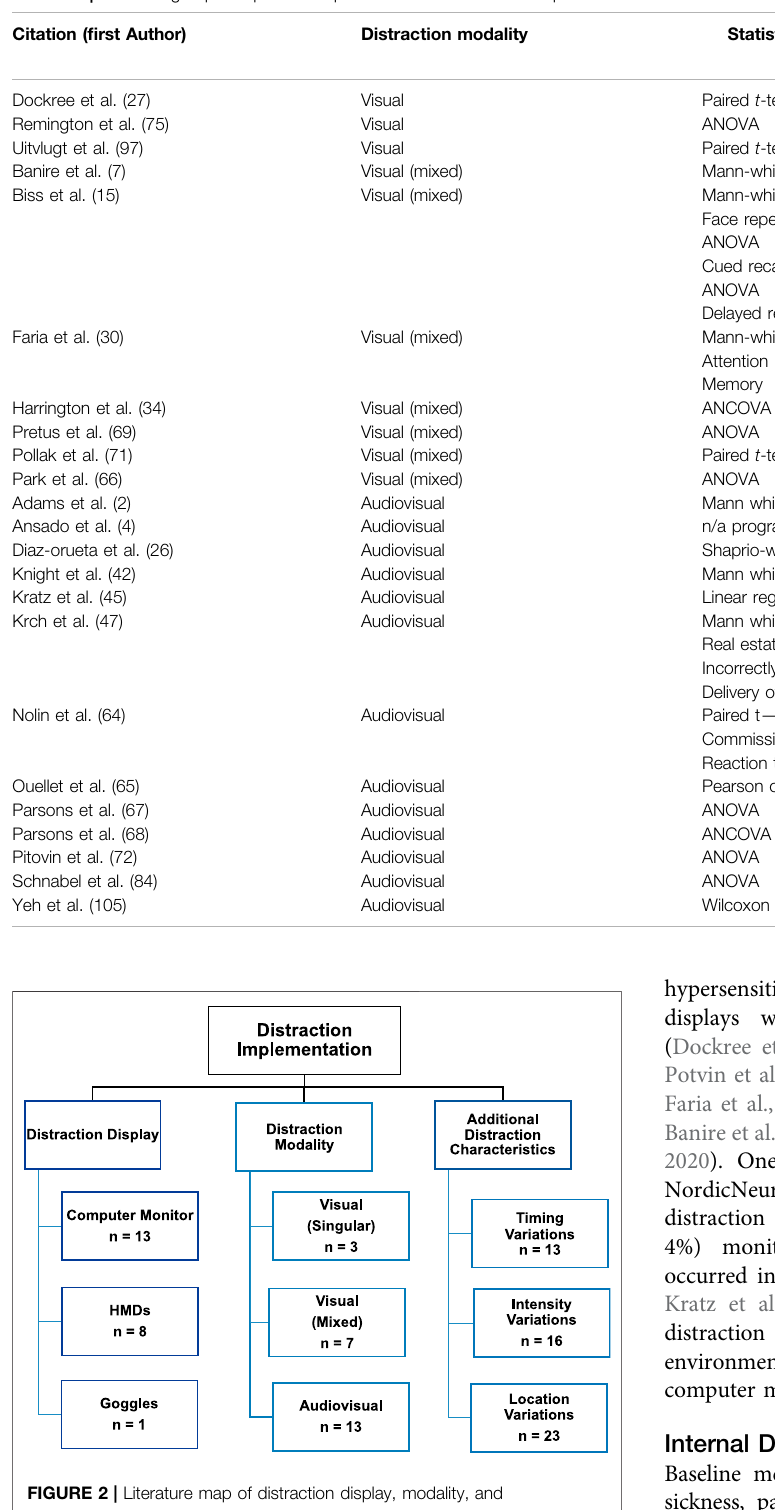
Frontiers in Virtual Reality |